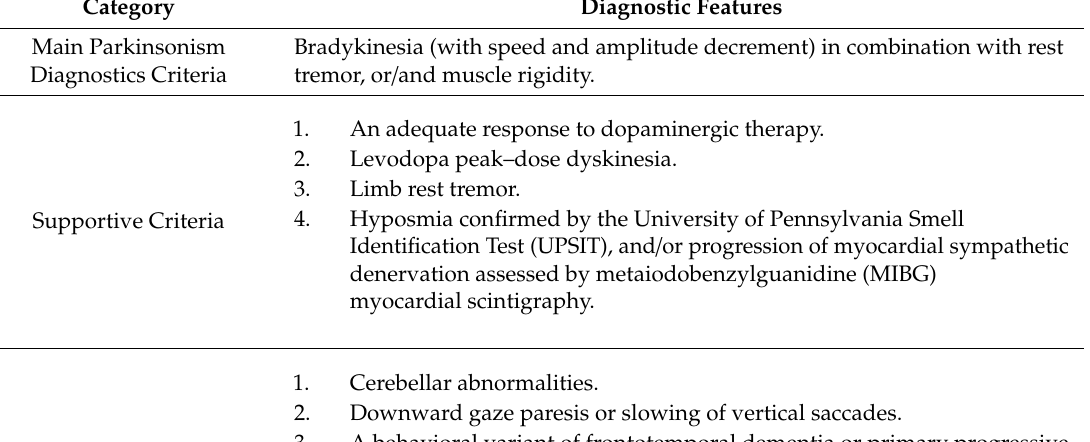
Table 1. The criteria for Parkinson’s disease (PD) diagnostics according to the Movement Disorder Society